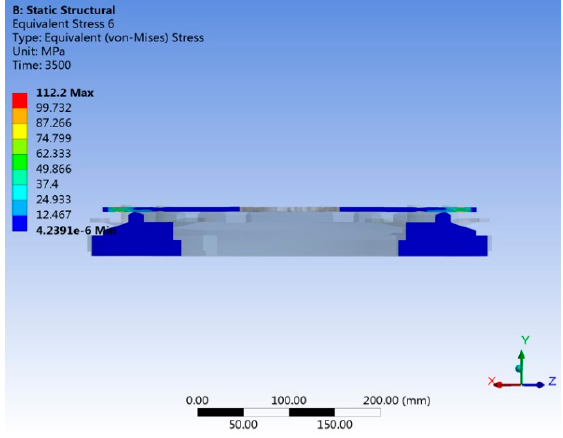
Figure 13. Stress distribution of pressure plate under constraint 1. Appl. Sci. 2019 , 9 , x FOR PEER REVIEW